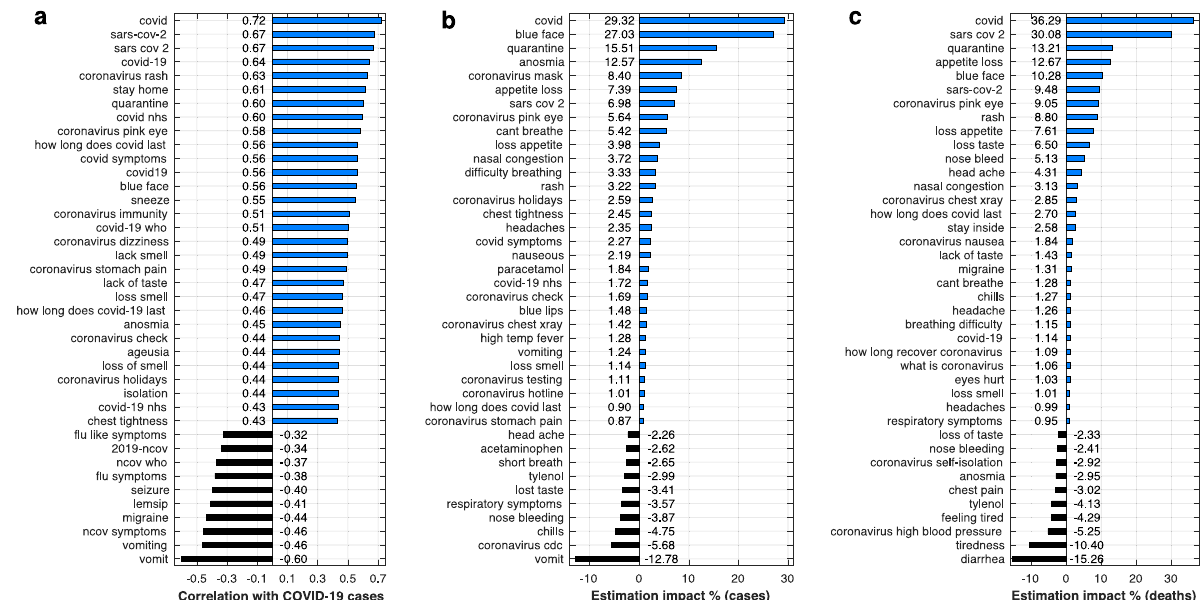
Fig. 4 Correlation and regression analysis of search query frequencies against con fi rmed COVID-19 cases or deaths in four English speaking countries (US, UK, Australia, and Canada). a Top-30 positively and top-10 negatively correlated search queries with COVID-19 con fi rmed cases; b Top-30 positively and top-10 negatively impactful queries in estimating COVID-19 con fi rmed cases; c Top-30 positively and top-10 negatively impactful queries in estimating deaths caused by